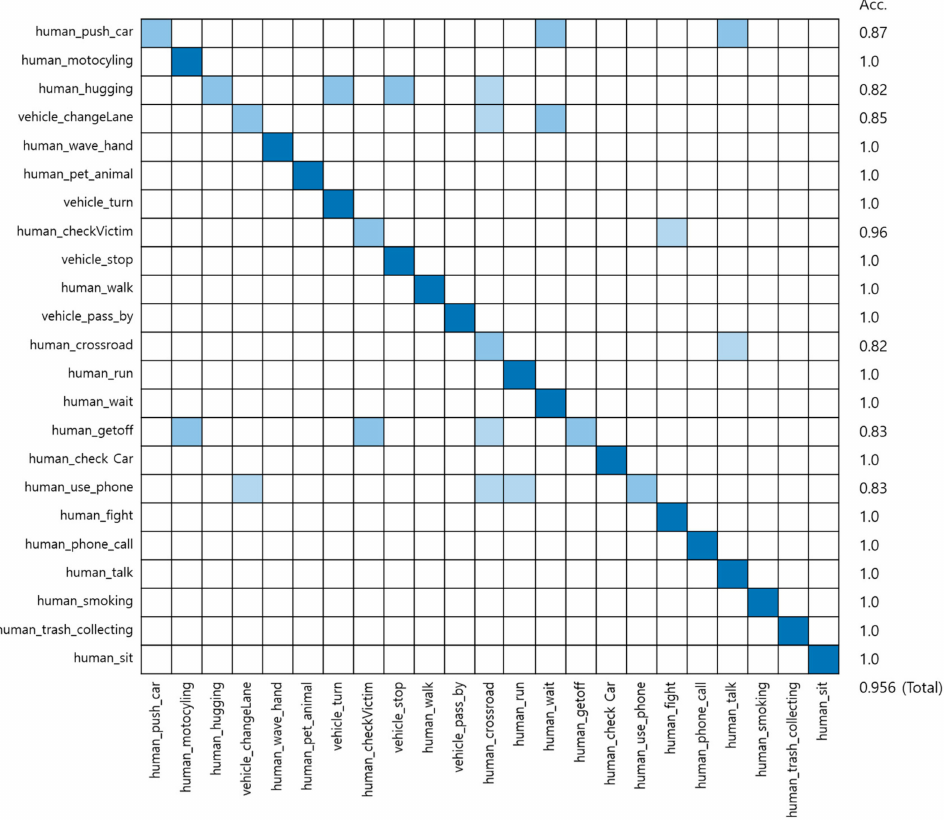
Figure 9. Confusion matrix of the LRCN result.